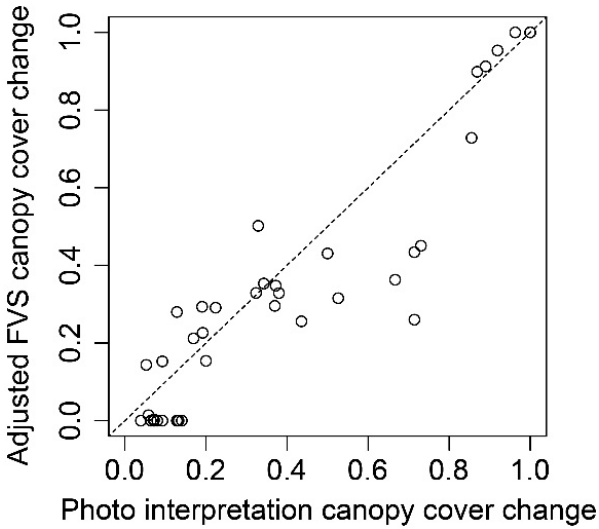
Figure A2. Photo interpretation canopy cover change versus scorch- and torch-adjusted FVS-gener-